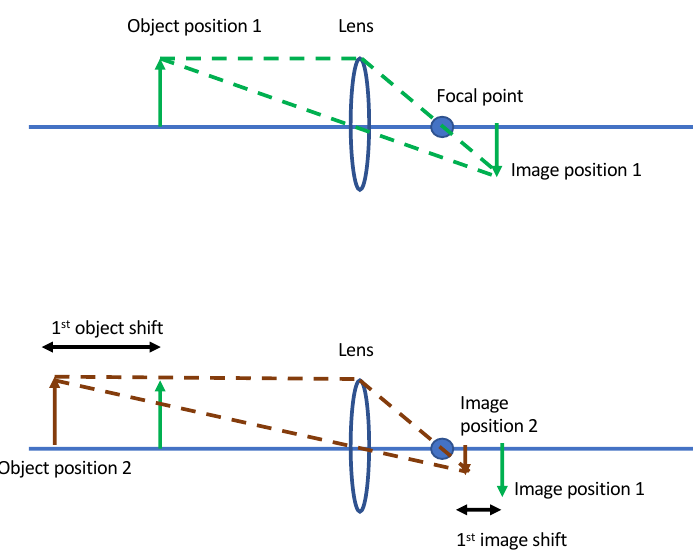
Figure 3. Ray diagram for backward movement with respect to static camera and effect on image captured by lens. Image recreated similar to shown in